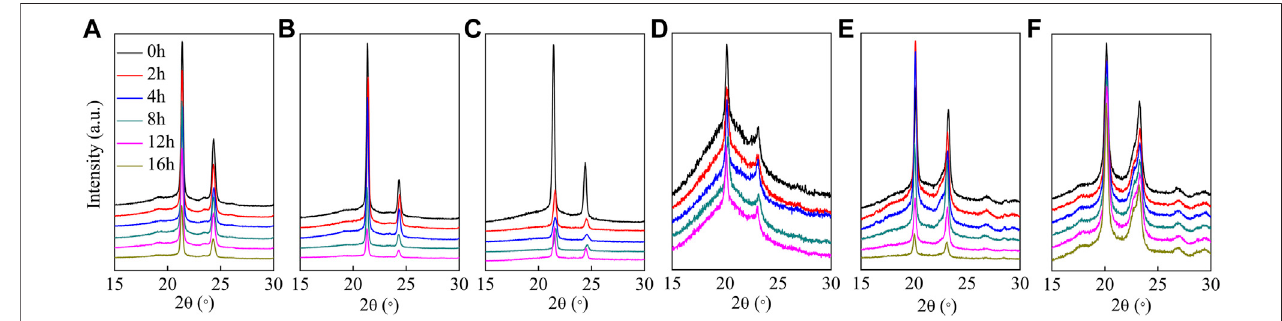
FIGURE 8 | XRD patterns of the polyesters at different extents of enzymatic hydrolysis. (A – F) : PHS, P(HS- co -13ES), P(HS- co -32ES), P(HS- co -51ES), P(HS- co - 76ES), and PES.